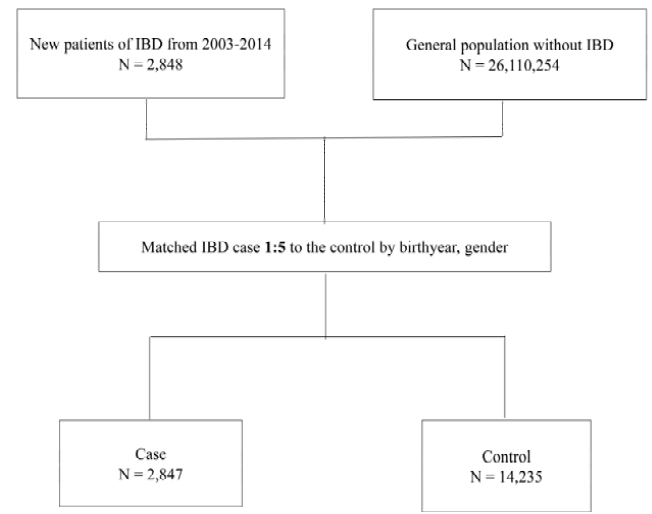
Figure 1. Flow chart of included patients for analyses. Table 1. Clinical characteristics of inflammatory bowel disease (IBD) patients and matched controls from 2003 to 2014. Figure1. Clinical